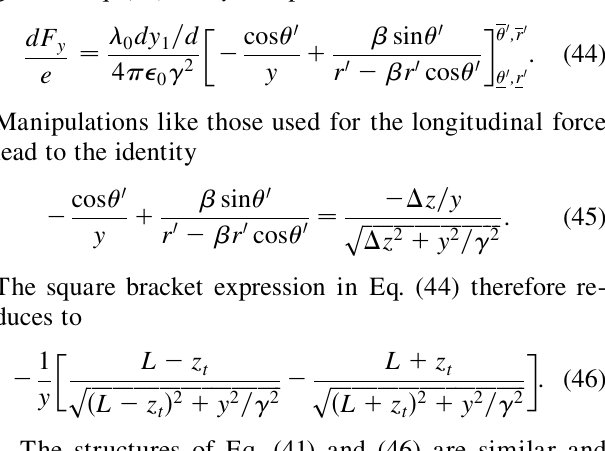
Fig. 6. An arc of charge, linear charge density (cid:9) along the arc of a circle of radius R with speed (cid:6)c . The single test charge (charge (cid:1) e , longitudinal position s transverse coordinates x; y , all relative to string center)